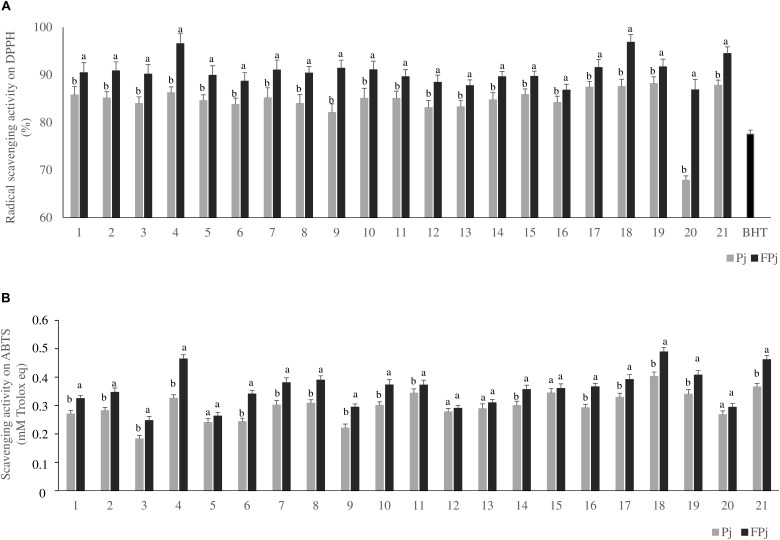
Radical scavenging activity on DPPH (panel A) and ABTS (panel B) of the pomegranate juices prior (Pj) and after (FPj) fermentation with Lactobacillus plantarum PU1. Error bars are shown. a,bDifferent superscript letters referred to significant (P < 0.05) difference between antioxidant activity of the juice prior and after fermentation.